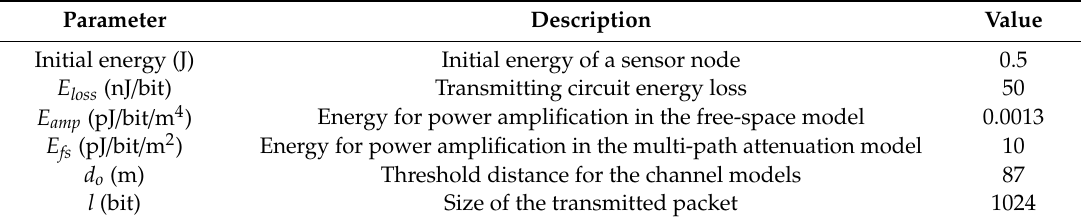
Table 7. Energy consumption model